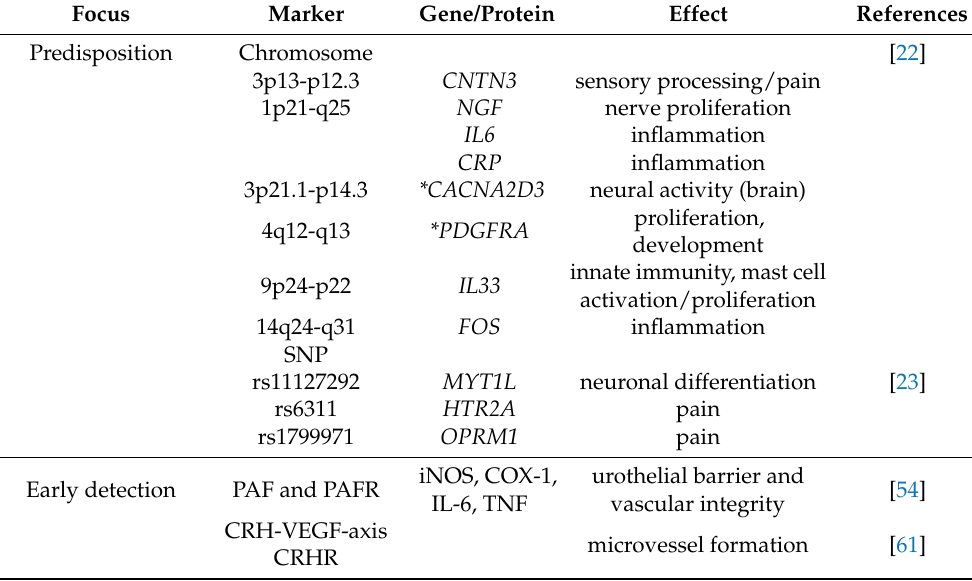
Table 2. Potential biomarkers related to etiopathology of